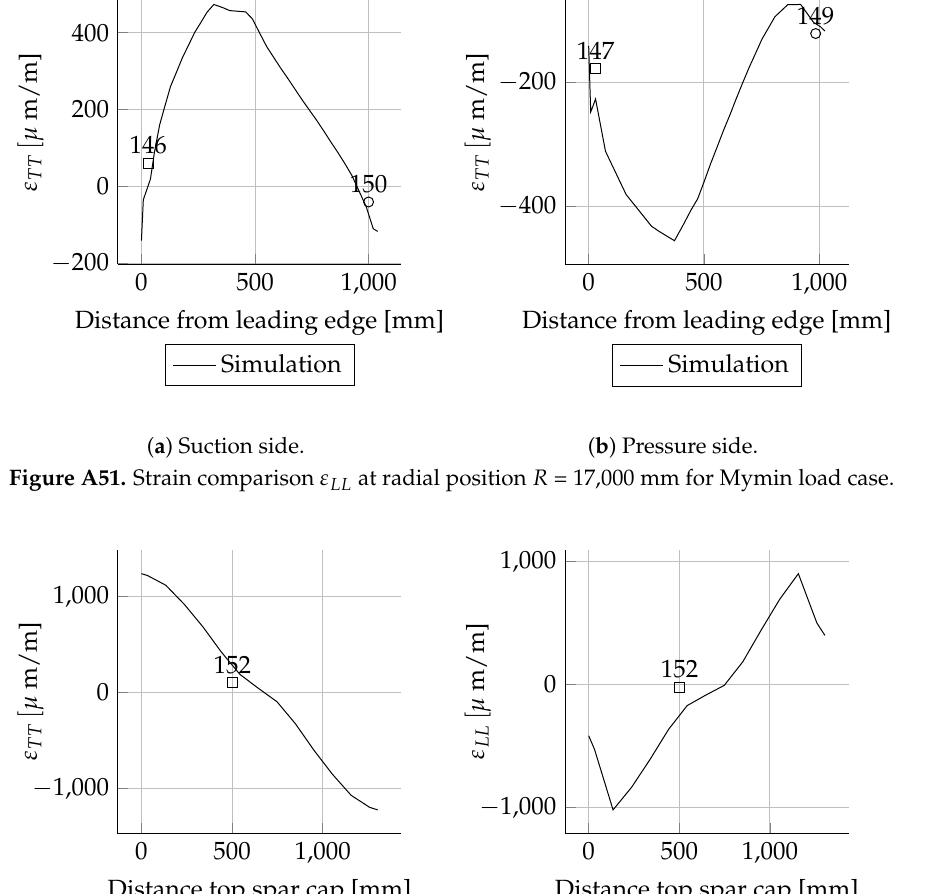
( a ) Strain comparison ε LL at 1600mm. ( b ) Strain comparison ε TT at 1600mm.